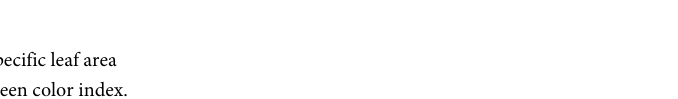
Table 4. Foliar parameters in Podocarpus macrophyllus seedlings subjected to combined treatments with blue, green, and red spectra and chitosan or water sprays (+Cos vs +Water) ( n = 6). Foliar